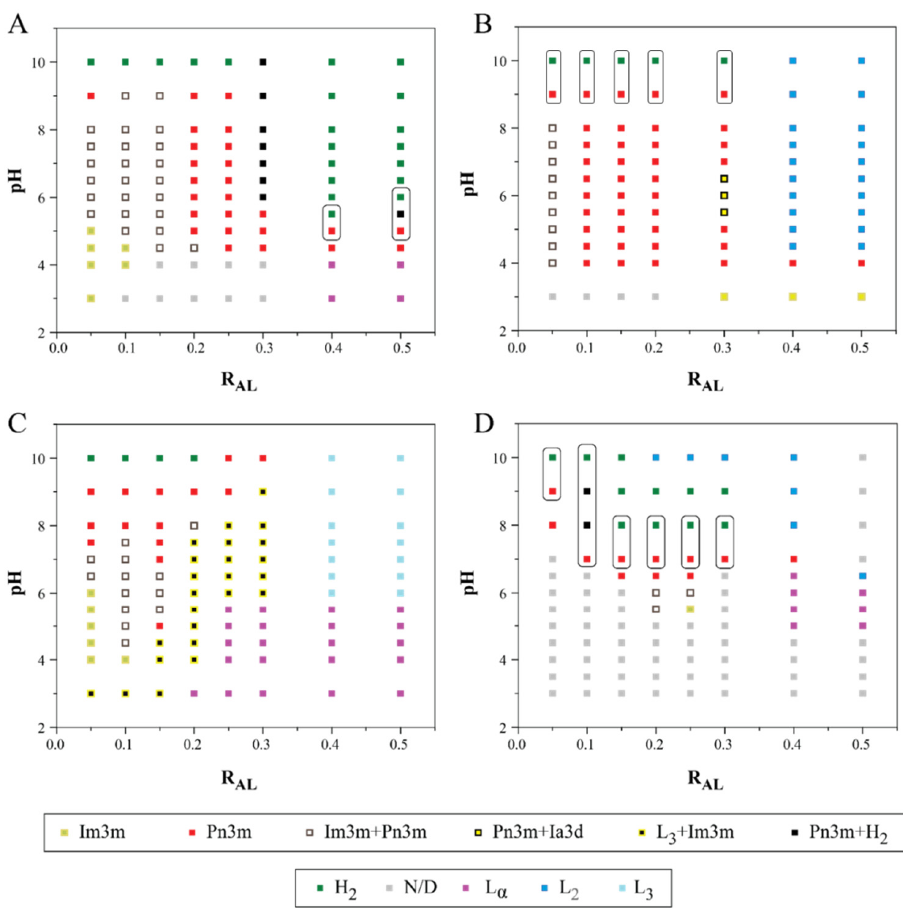
Figure 3. SAXS derived partial phase diagrams at RT for LNPs prepared by adding aminolipid to MO at pH 3–10. The boxes highlight the desired hexagonal (H 2 ) to cubic (Q 2 ) phase transition as pH drops. Partial phase diagrams for nanoparticles obtained by incorporating ( A ) OAPy-4, ( B ) OAPy-2, ( C ) OAMo-1, and ( D ) OAPi-1. R AL represents the weight ratio of aminolipid to the total weight of lipids in the system. Identifiable phases include bicontinuous cubic (Im3m, Pn3m, and Ia3d), sponge phase (L 3 ), inverse micelles (L 2 ), hexagonal (H 2 ), and lamellar (L α ). N/D indicates a nonidentifiable phase.